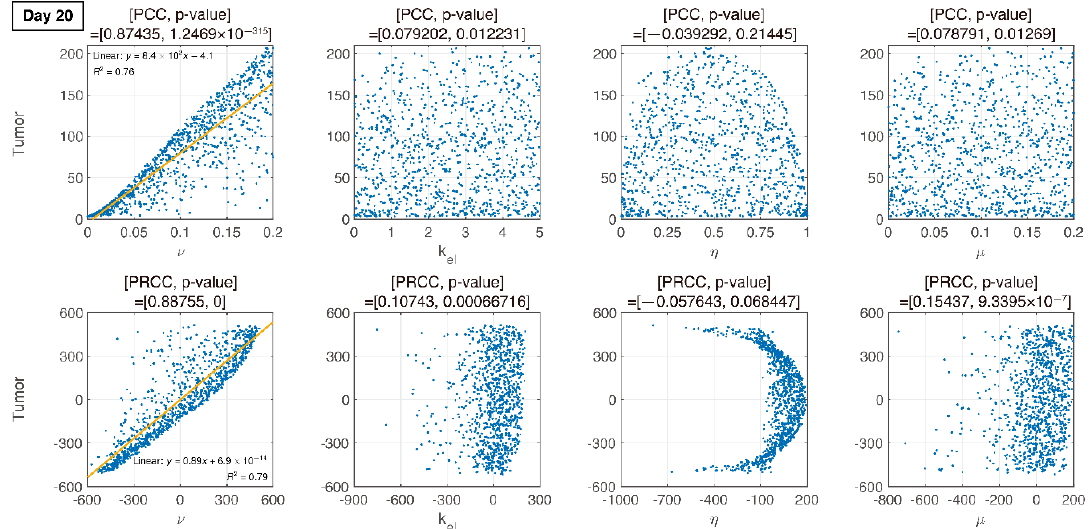
Figure 8. On day 20 (during IT therapy and after IR therapy), PRCC and p-values of four parameters are determined. An increase in 𝜈 is proportional to tumor growth, but other parameters have little influence.